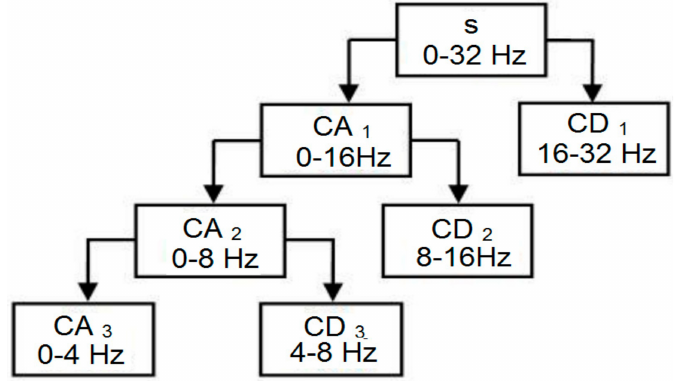
Figure 3. Sub-band coding